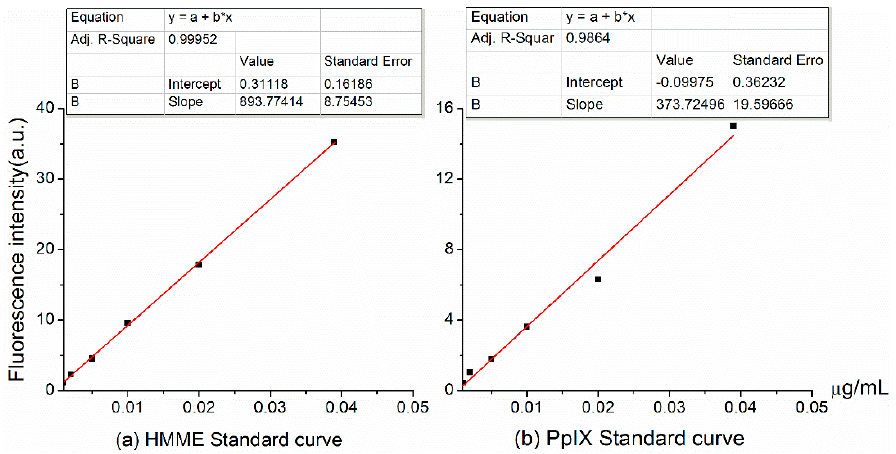
Figure 2. Standard curves of photosensitizer concentrations. ( a ) Hematoporphyrin monomethyl ether; ( b ) protoporphyrin IX.